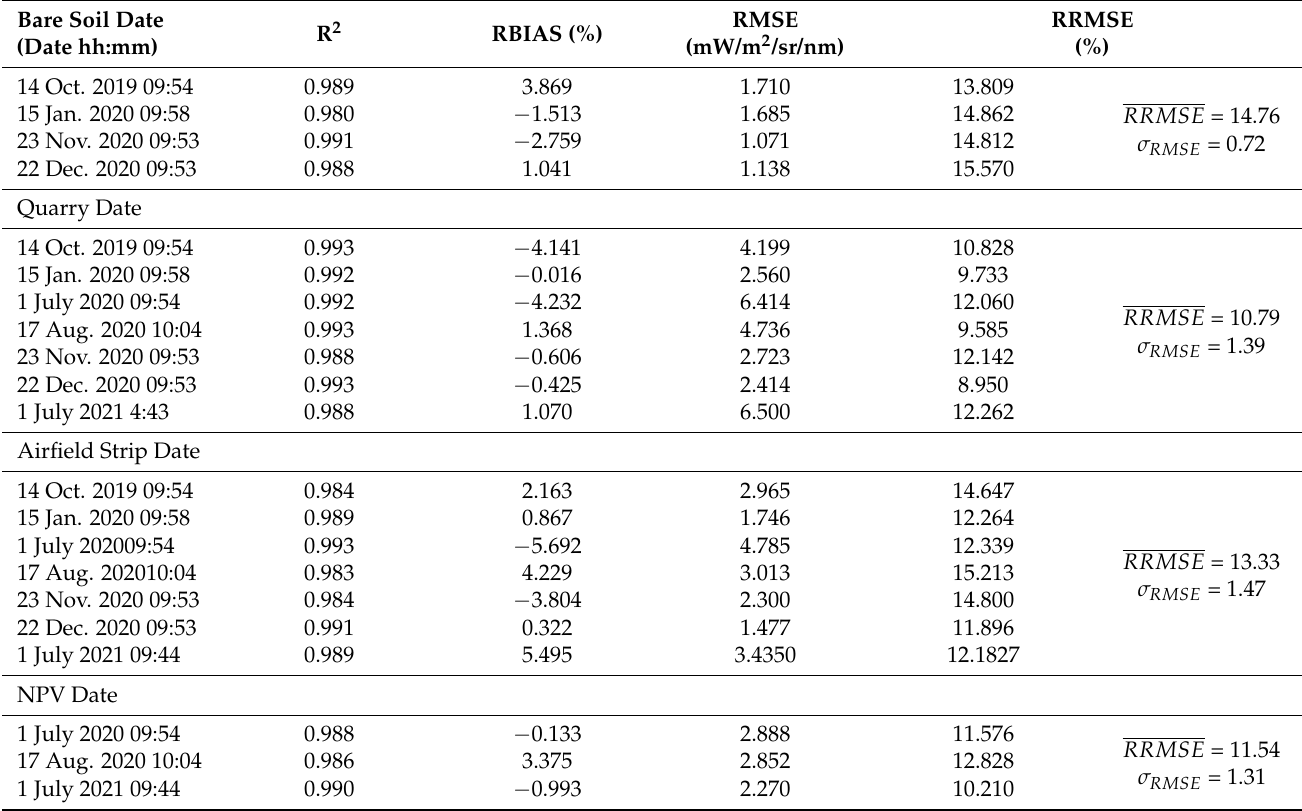
consistency for each target and PRISMA